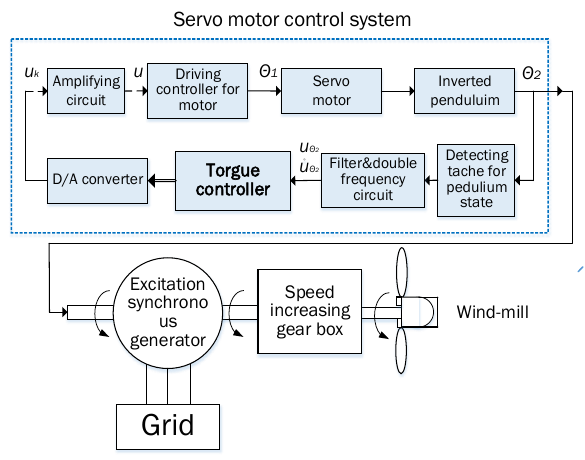
Fig. 2. The wind power system framework.